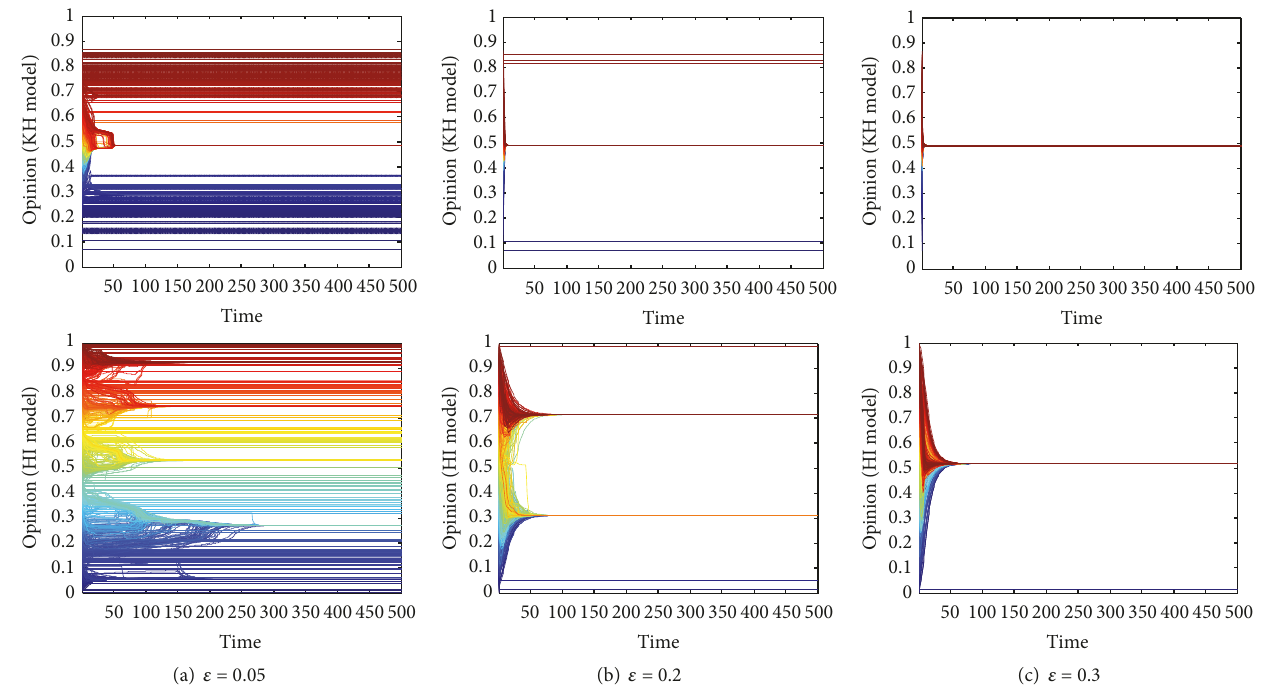
Figure 6: The comparison of public opinion evolution between KH model (the above three figures) and HI model (the three figures below) in the scale-free network. 𝜀 : (a) 𝜀 = 0.05, (b) 𝜀 = 0.2, and (c) 𝜀 =